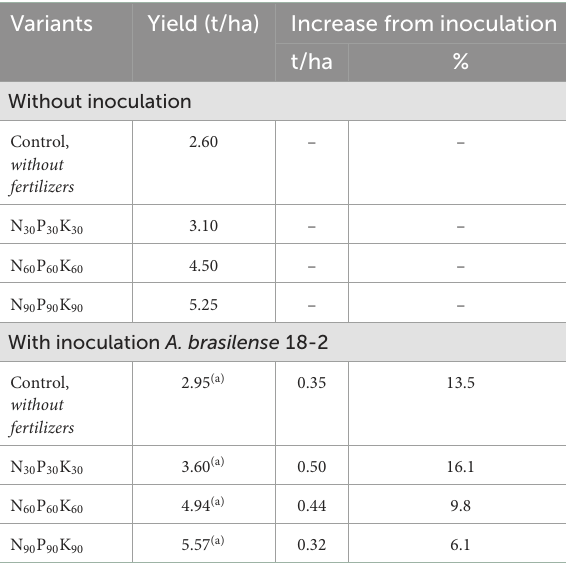
TABLE 5 The effect of fertilizers and pre-sowing seeds inoculation with A. brasilense 18-2 on winter rye yield (prorated to “per hectare” basis) Variants Yield (t/ha) Without With inoculation inoculation